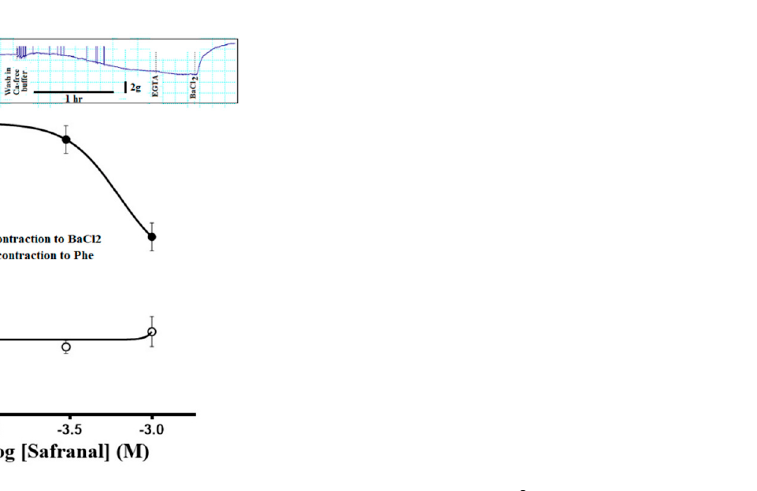
Figure 5. The phasic contractions induced by phenylephrine in a Ca 2+- free buffer (open circles) are not affected by safranal, whereas contractions induced by 3 × 10 − 2 M BaCl 2 (closed circles) are inhibited by increasing safranal concentration. Inset in the upper part of the figure represents a sample experiment for clarification. n = 6.